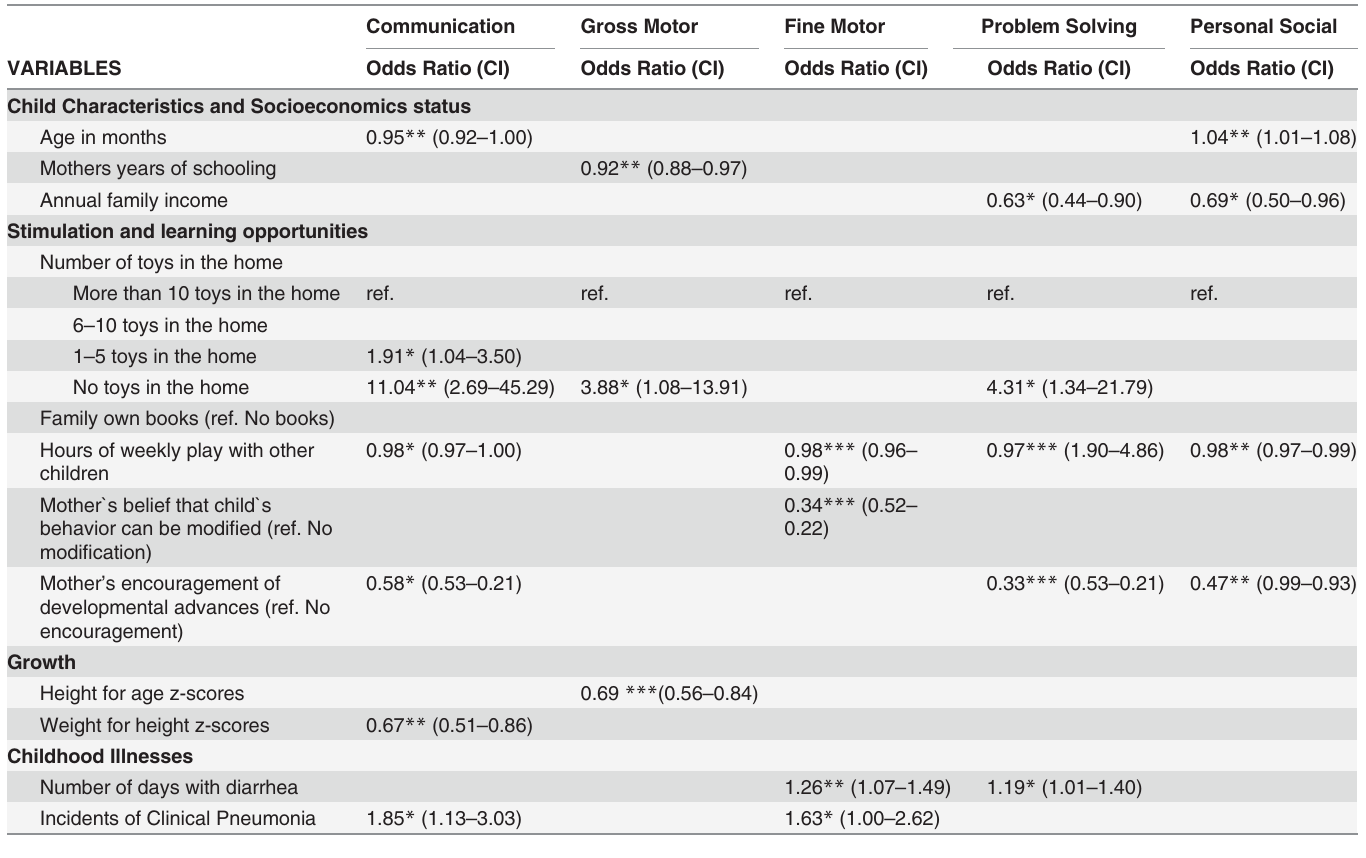
Table 3. Variables predicting ASQ-3 subscale score in North Indian children 12 – 36 months 1